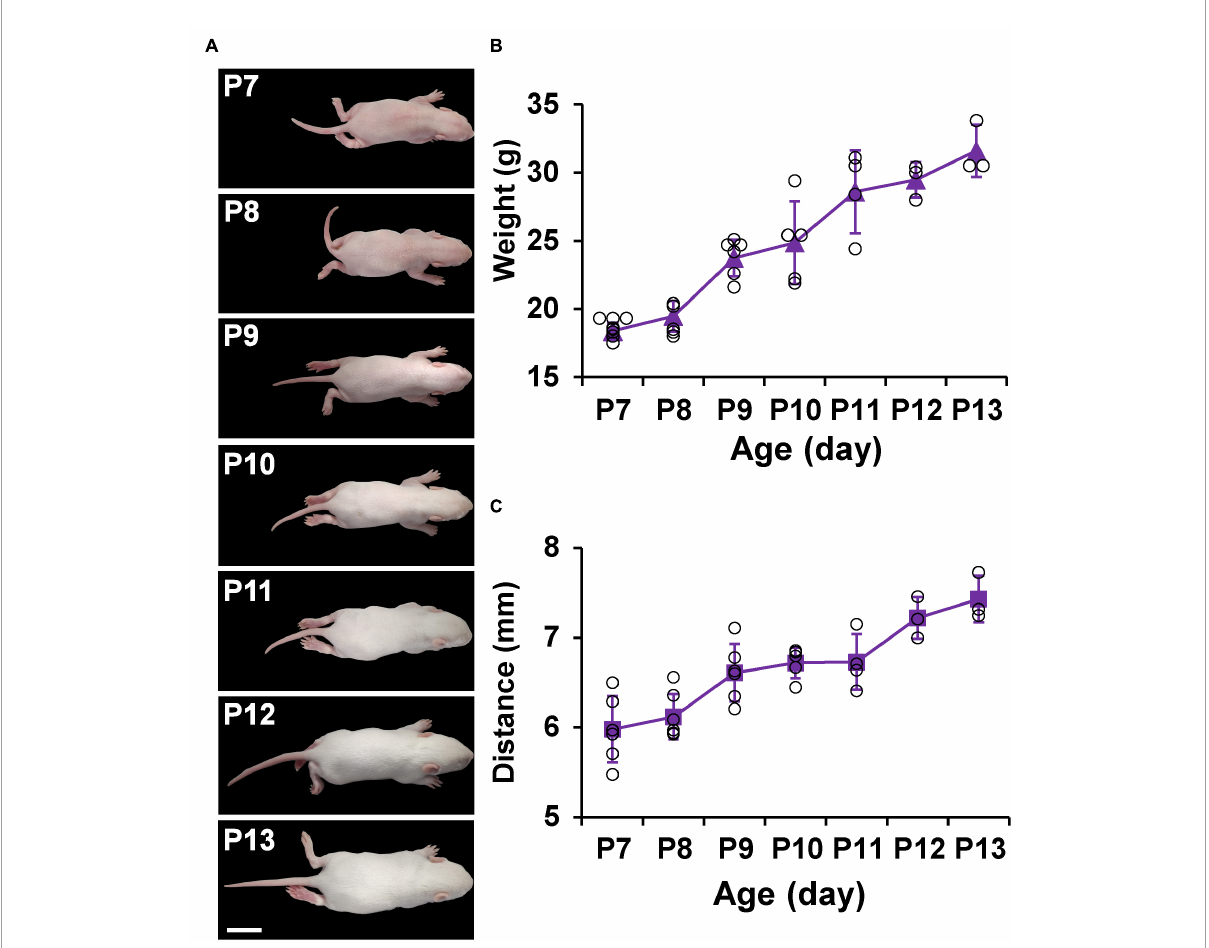
FIGURE4 Appearance and measurements of P7–P13 pups. (A) The dorsal view of the representative pups shows an increase in body size and a change in body color from pink to white. (B) Average body weight change in pups. (C) Average distance between bregma and lambda change in pups. Values are means ± SEM ( n = 3–7). Bar = 2